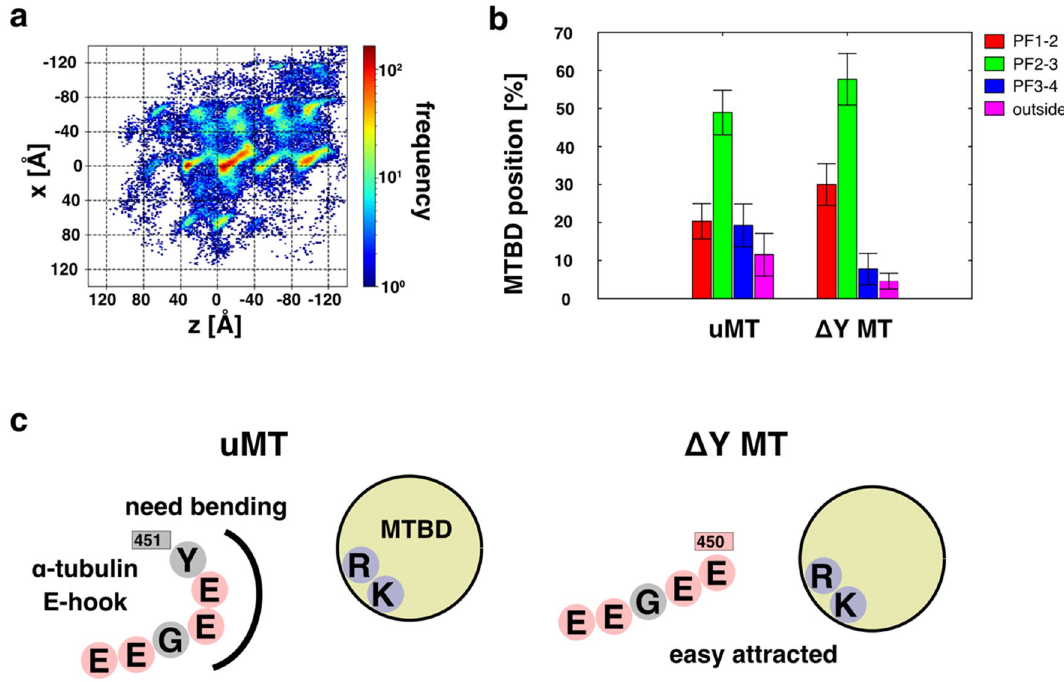
Figure 2. Low-affinity state dynein with detyrosinated MT. ( a ) Heat map of the position of the low-affinity state MTBD on the ΔY MT, with 20 trajectories overlaid. The coloring method is same with Fig. 1d. ( b ) Probability of localization of MTBD on the uMT and ΔY MT for each binding lane; PF -1 , PF 0 , PF 1 , and other percentages are red, green, orange, and blue, respectively. ( c ) The detyrosinated CTT seems to have an easier contact MTBD than unmodified CTT. The positively charged ARG and LYS are blue, the negatively charged GLU and ASP are red, and the other are